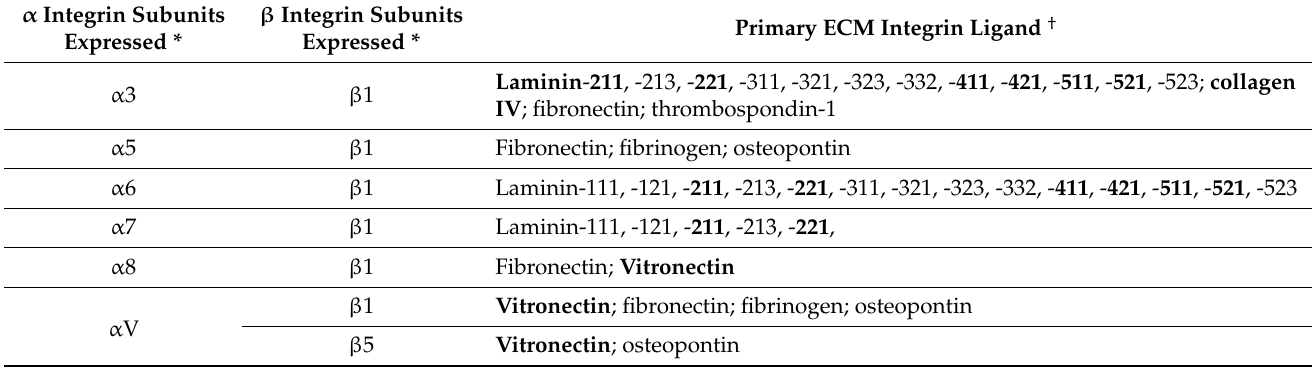
Table 1. Integrin and ECM protein expression in human cardiac